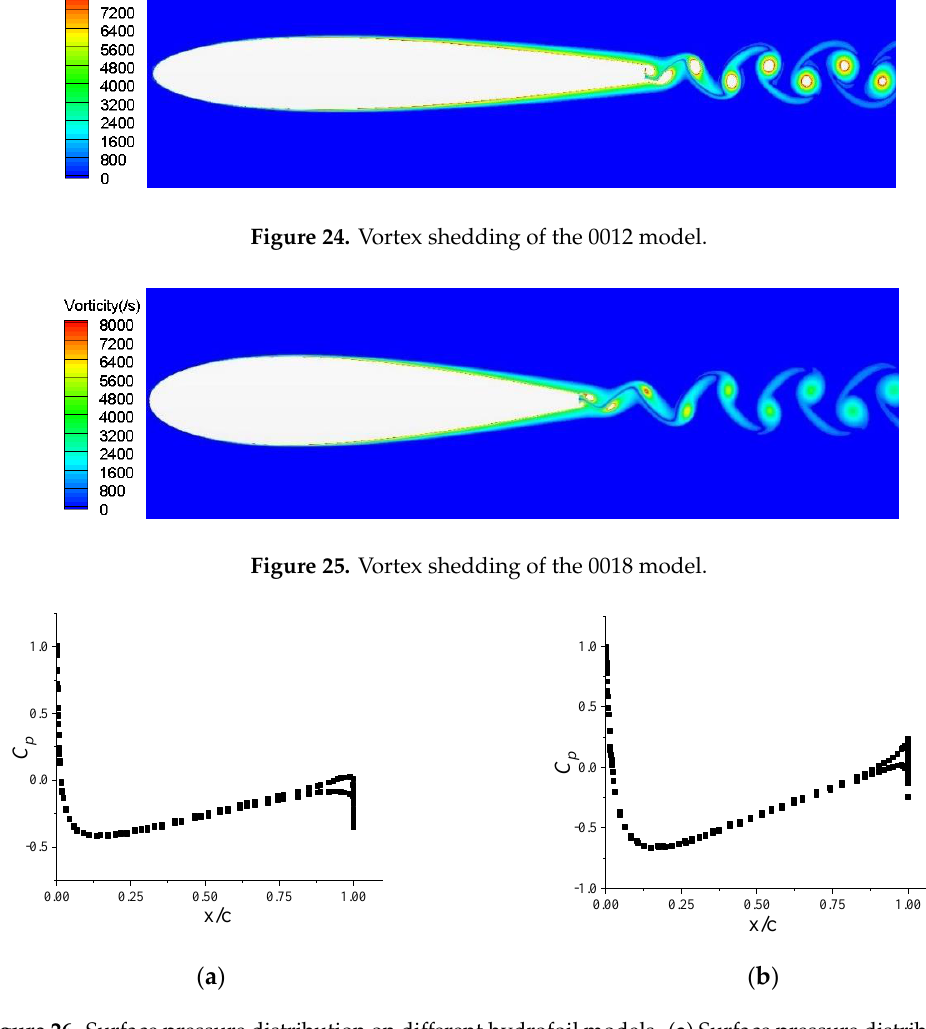
Figure 26. Surface pressure distribution on different hydrofoil models. ( a ) Surface pressure distribution of Model 0012 ( 𝐶 𝑙 = 0.0282). ( b ) Surface pressure distribution of Model 0018 ( 𝐶 𝑙 = −0.0232).